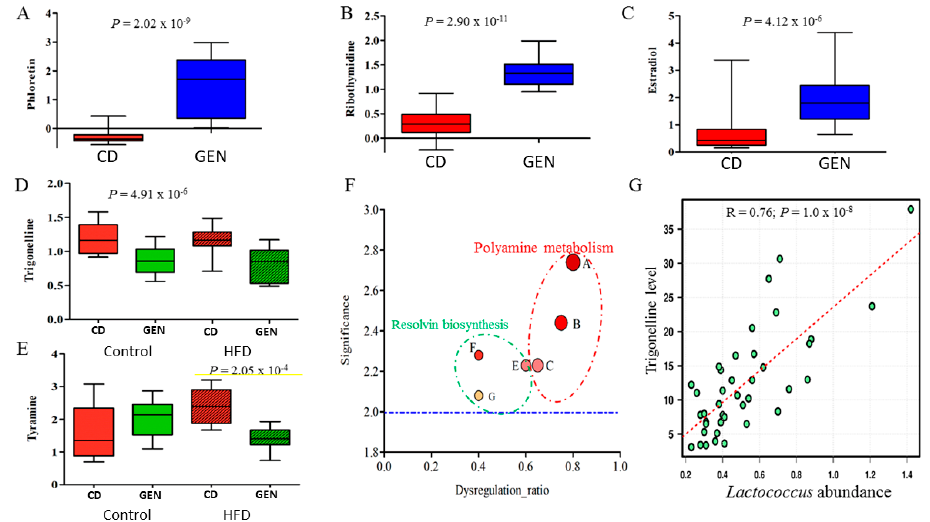
Figure 8. The gut metabolome is significantly impacted by genistein (GEN) supplementation. The level of select fecal metabolites that were significantly increased by GEN supplementation, compared with non-supplemented state, regardless of maternal dietary exposure: ( A ) phloretin, ( B ) ribothymidine, and ( C ) estradiol. Abundance of some metabolites were similarly reduced by GEN supplementation in the control and HFD offspring: ( D ) trigonelline; and some were reduced only in the HFD offspring ( E ): tyramine. ( F ) Additional select pathways which were significantly affected by GEN supplementation only in the HFD offspring. The selected pathways were: A, spermine biosynthesis; B, spermidine biosynthesis; C, spermine and spermidine degradation; E, aspirin triggered resolvin E biosynthesis , the yellow line is designed to highlight the significance; F, aspirin triggered resolvin D biosynthesis; and G, resolvin D biosynthesis. Significance was defined as -log 10 p value. The blue dashed line represented significance of p = 0.01. The Dysregulation ratio was defined as the number of dysregulated to the number of total metabolites detected in the dataset that were assigned to a given pathway. ( G ) The linear correlation between the relative abundance of the genus Lactococcus and the fecal trigonelline level.